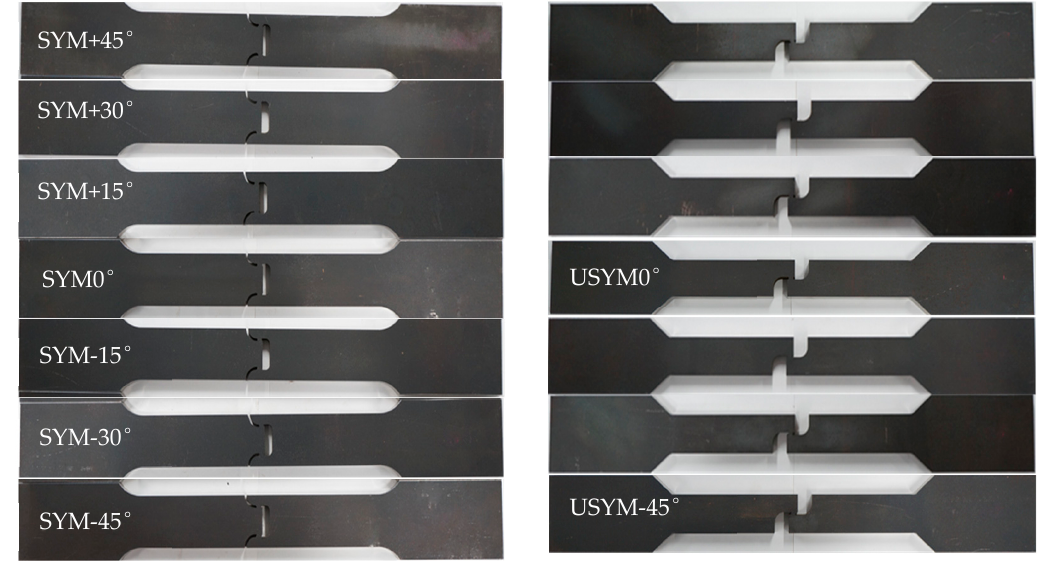
( b ) Detailed dimensions of the notch. (unit: mm).